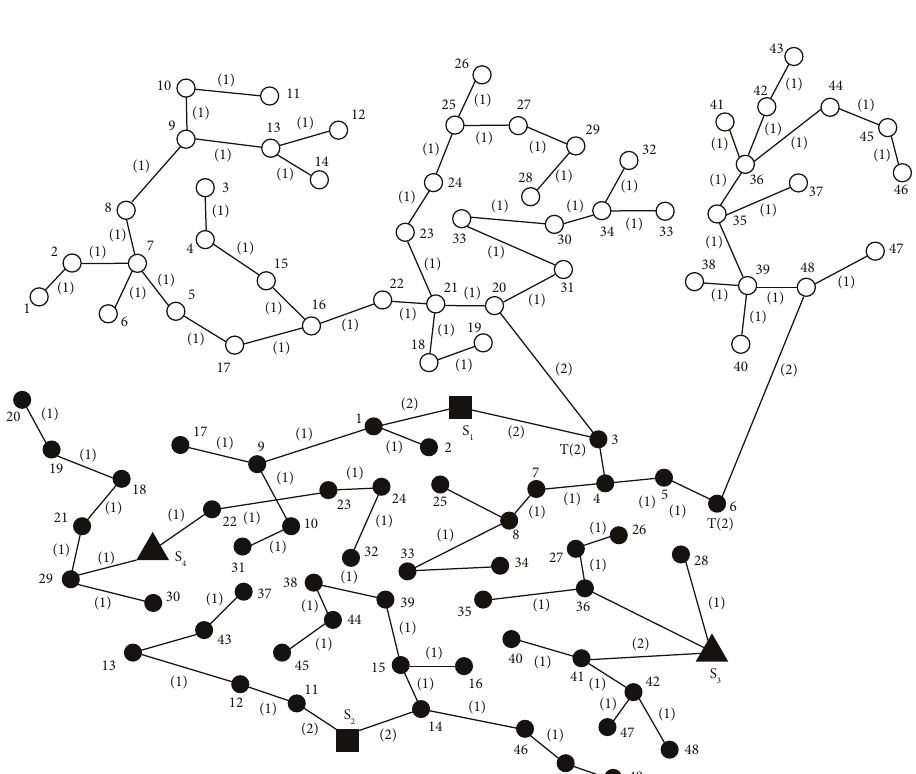
Figure 8: Configuration of the network in